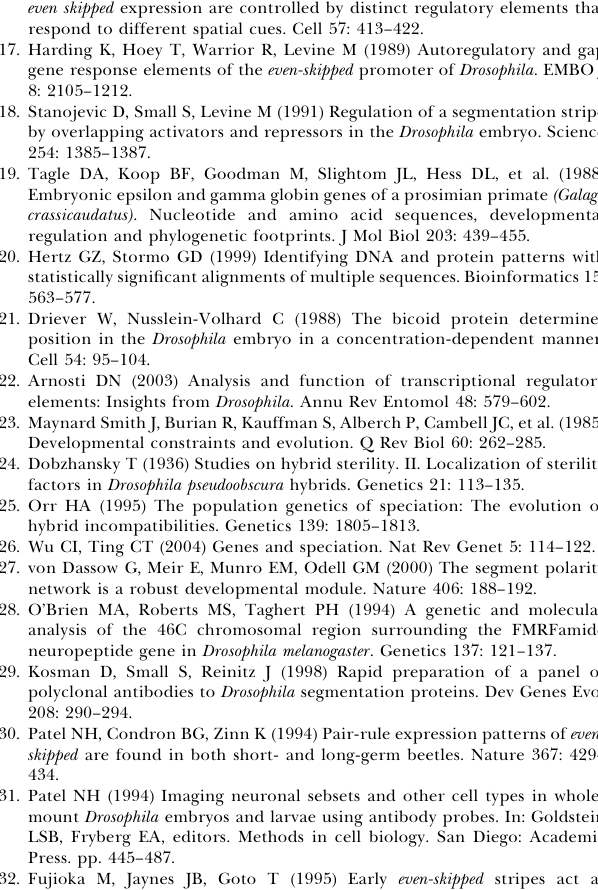
Table S2. ANOVAs on EVE Abundance in Stripe 2 ANOVAsonEVEquantity.(A)AnalysisonamountsofEVEinstripe2 D. erecta and D. pseudoobscura rescue data (B) on the rescue data for all four species and (C) the EVE D S2E/Cy stock. Mixed-model ANOVA (left) fittedthemultiplemeasuresperembryoasrandom.Generalizedlinear